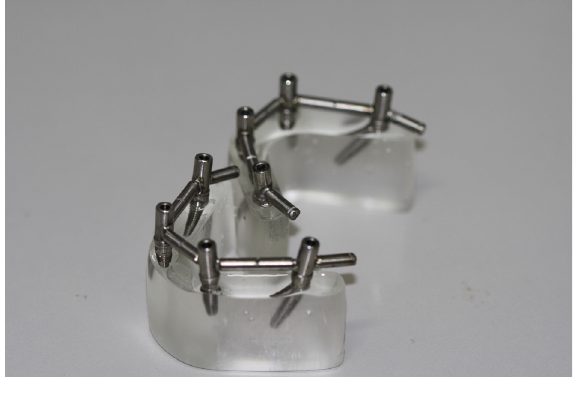
Figure. 1: Photoelastic model (GIV Flexible Silicone Rubber and ASB - 10 Blue - POLIPOX ®